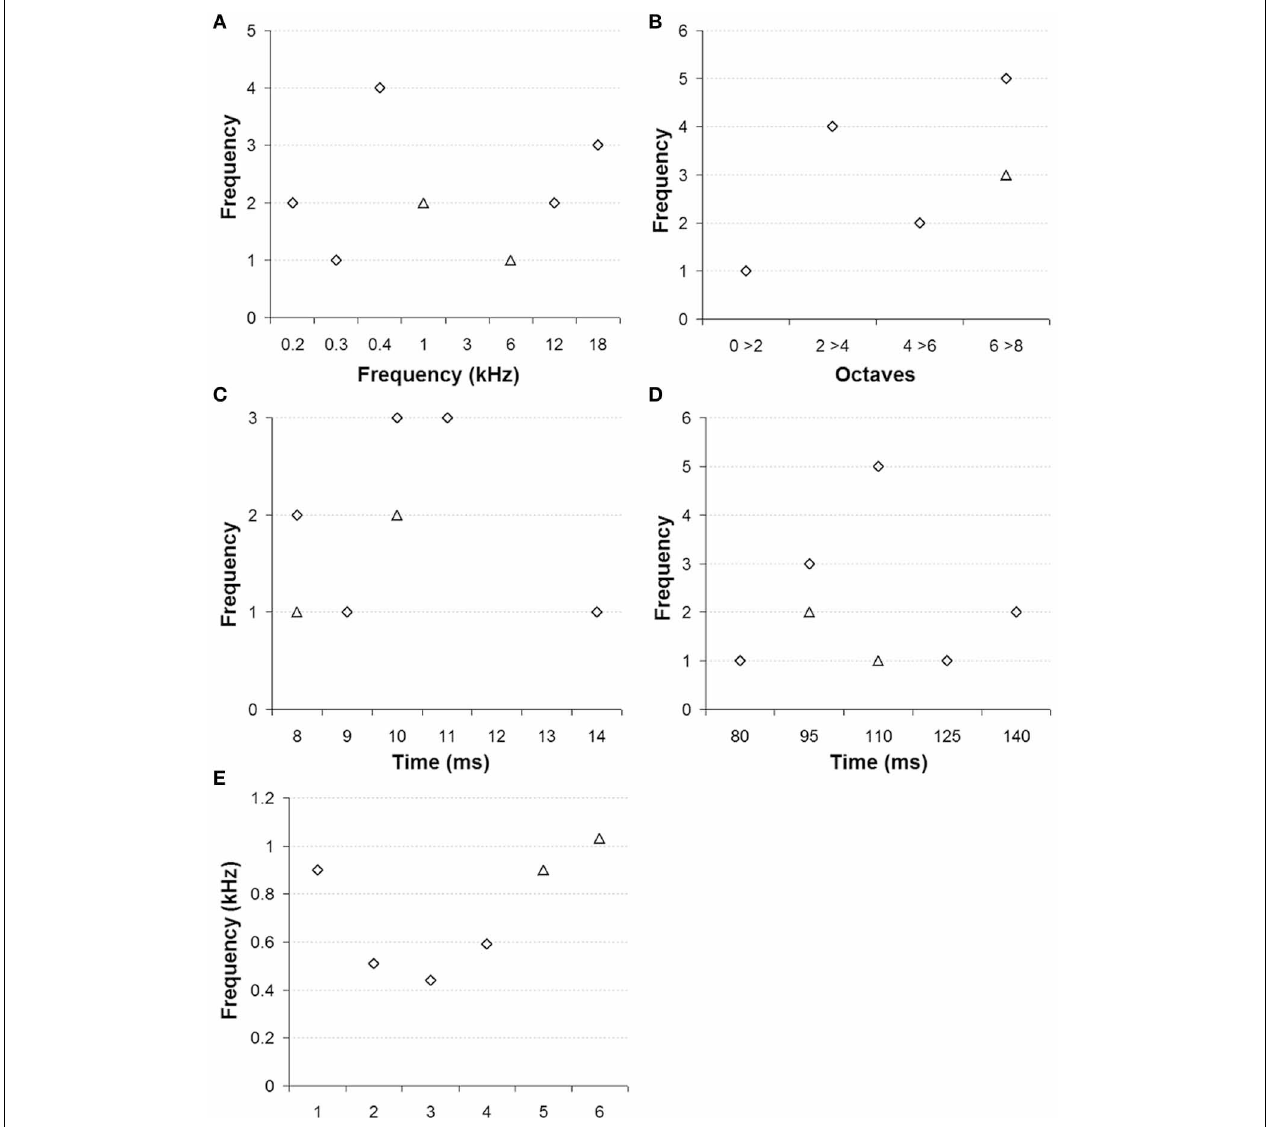
FIGURE 4 | Tonal selectivity of multiunit activity in red nucleus. (A) Best frequency, (B) Tuning curve bandwidths in octaves, (C) Latency of the first spike, (D) Latency of the last spike, and (E) Maximum frequency of phase locking (monkey E: diamonds, monkey W: triangles).